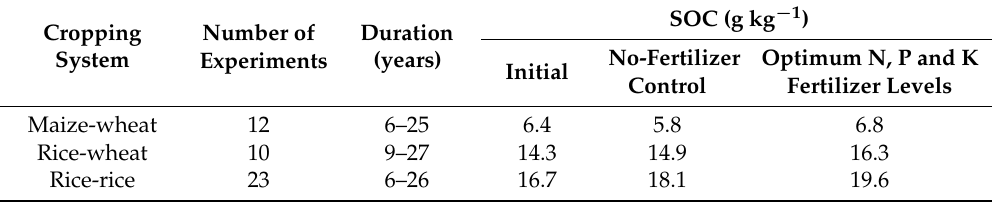
Table 4. Average SOC content at the start (initial) of long-term experiments on maize-wheat, rice-wheat, and rice-rice cropping systems and in no-fertilizer (N, P, and K) control and optimum N, P, and K fertilizer level treatments at the end of the experiments in different locations in